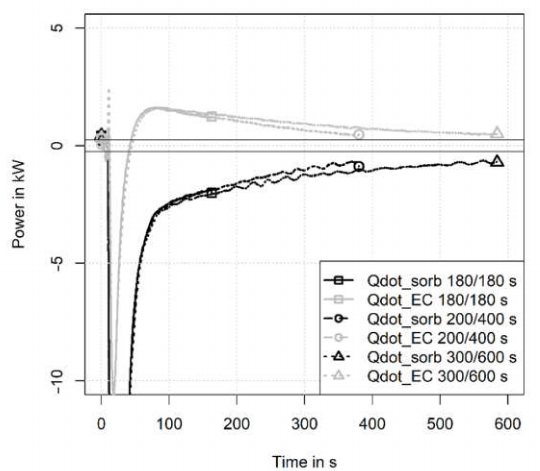
Figure 9. Calculated power of adsorption heat exchanger and evaporator-condenser over the ad- sorption half cycle for different half cycle times. Temperature boundary conditions are 10/35/95 ◦ C, volume flow rate is kept constant at 10 l/min for each heat exchanger throughout the whole measure- ment. The two horizontal lines indicate − 250 W and 250 W, respectively. The error bars are below the thickness of the plotted lines.